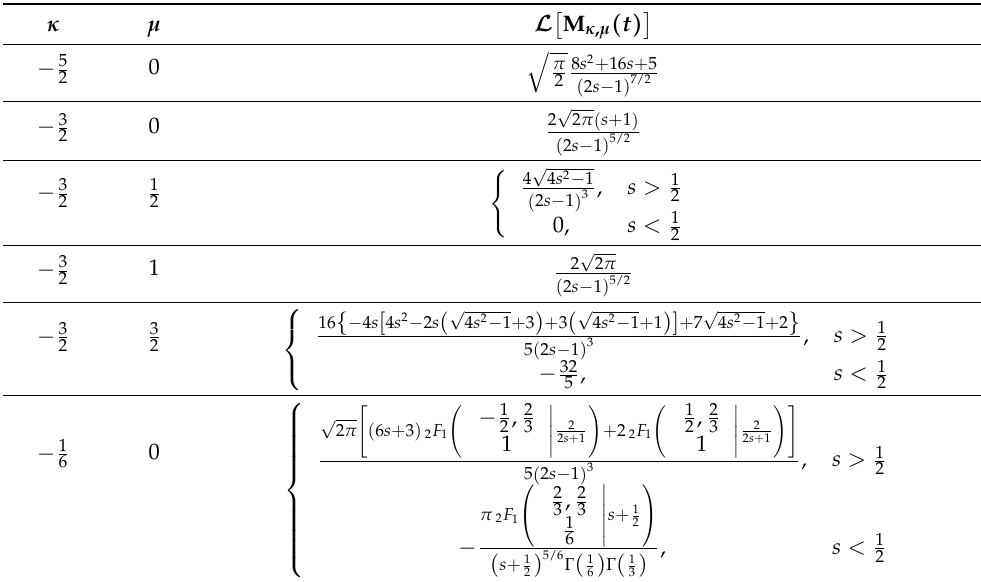
Table A7. The Laplace transforms of the Whittaker function M κ , µ derived for some values of parameters κ and µ